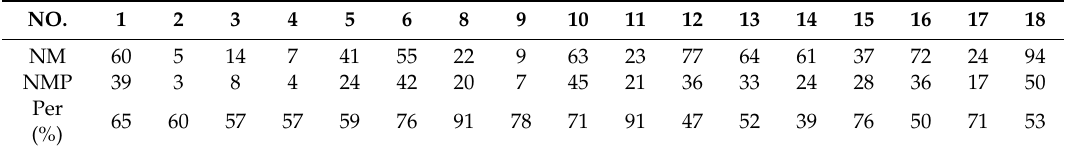
Table 4. The statistics of defects based on the defects mapping and peaks of the similarity